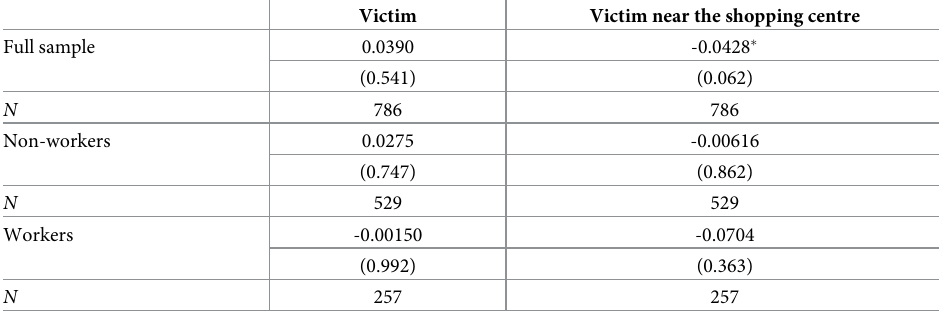
Table 8. Difference-in-differences estimates of the effect on